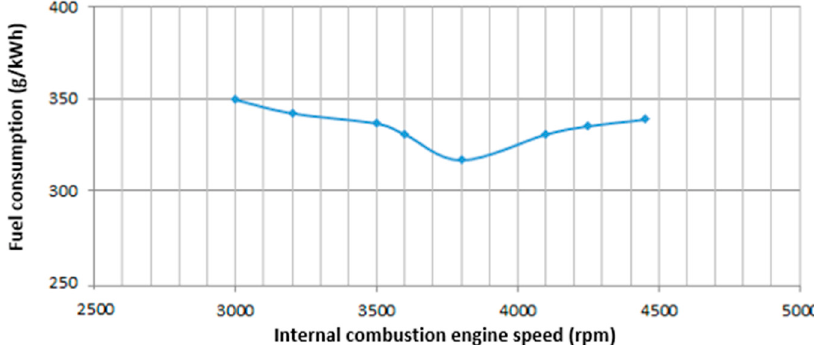
Figure 4. Fuel consumption of combustion engine when it connects with the compressor.